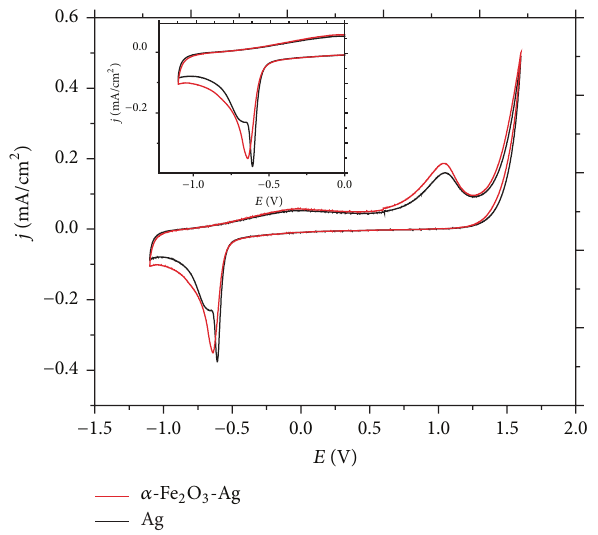
Figure 5: Cyclic voltammograms of the 𝛼 -Fe 2 O 3 -Ag and Ag nanoparticles in acid medium employed a solution of H 2 SO 4 (0.5 M). Scan rate 50 mVs −1 at 25 ∘ C in presence of N 2